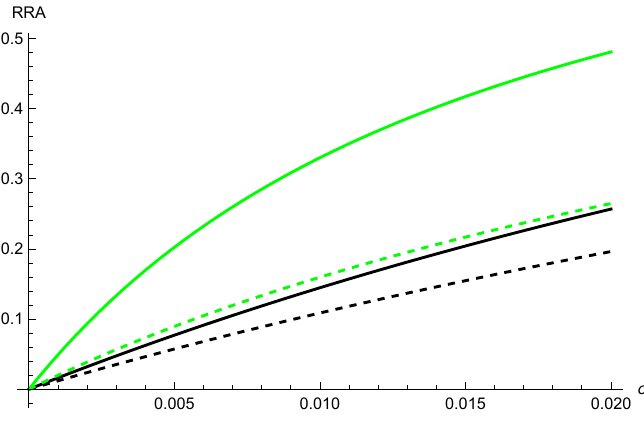
Figure 8. Relative risk adjustment as a function of σ . Here the green lines correspond to T = 60 and the black lines to T = 20, further the dashed lines have r = 0.90 and the solid lines have r =